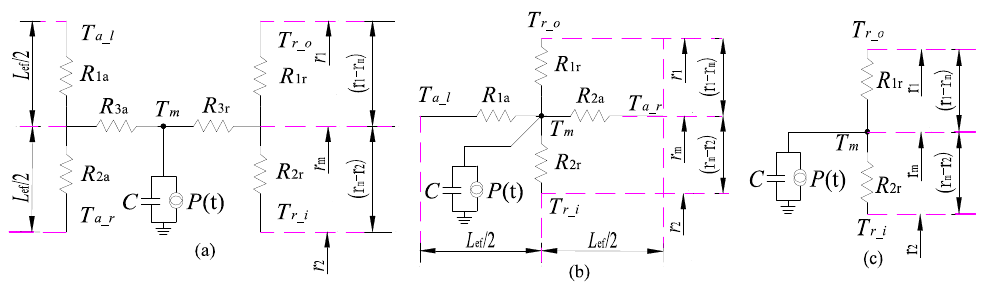
Figure 2. Definition of thermal network unit. ( a ) “H” type, ( b ) “+” type, ( c ) “I” type. Heat resistance R cond is the inverse of heat conductance G cond , which is given by [14]